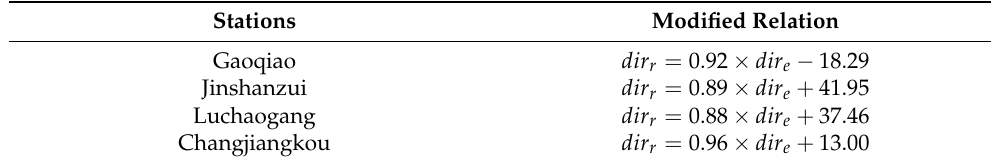
Table 1. Correction equations of wind direction at each